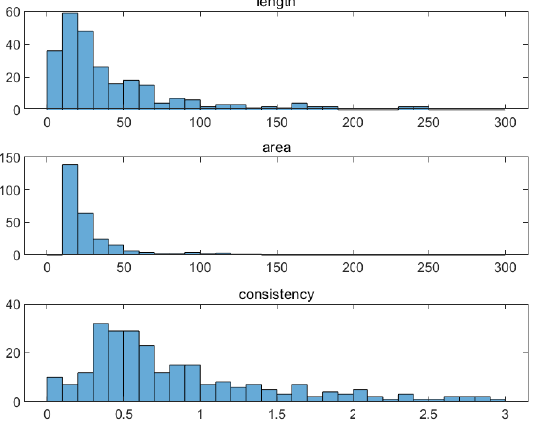
Figure 9. The histogram of three parameters of different water